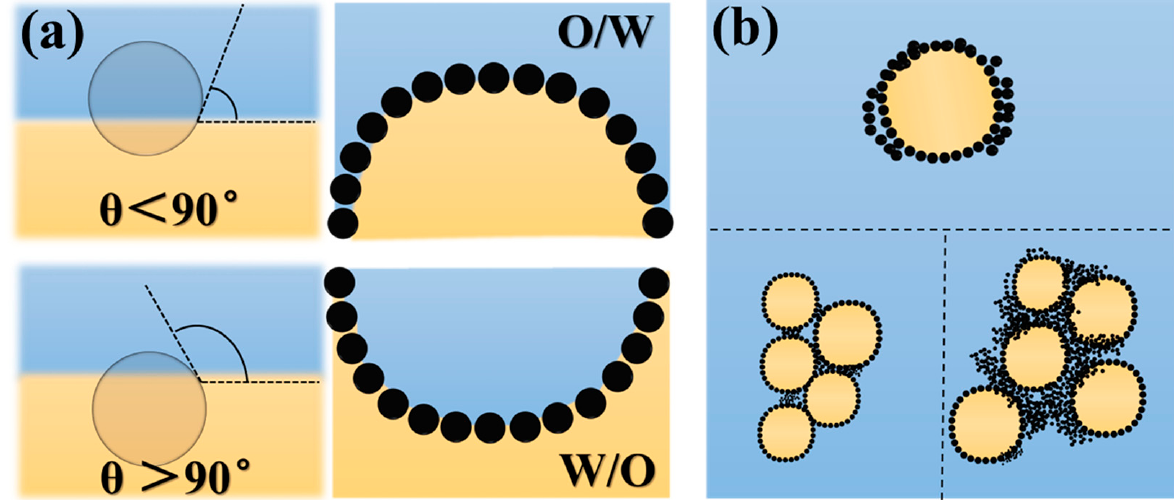
Figure 1. The oil phase (noted O) is in yellow, that the water phase (noted W) is in blue, and the black particles correspond to solid particles adsorbed at the interface. ( a ) Correlation of solid particle contact angle and Pickering emulsion type. ( b ) Structural characteristics of Pickering emulsion.